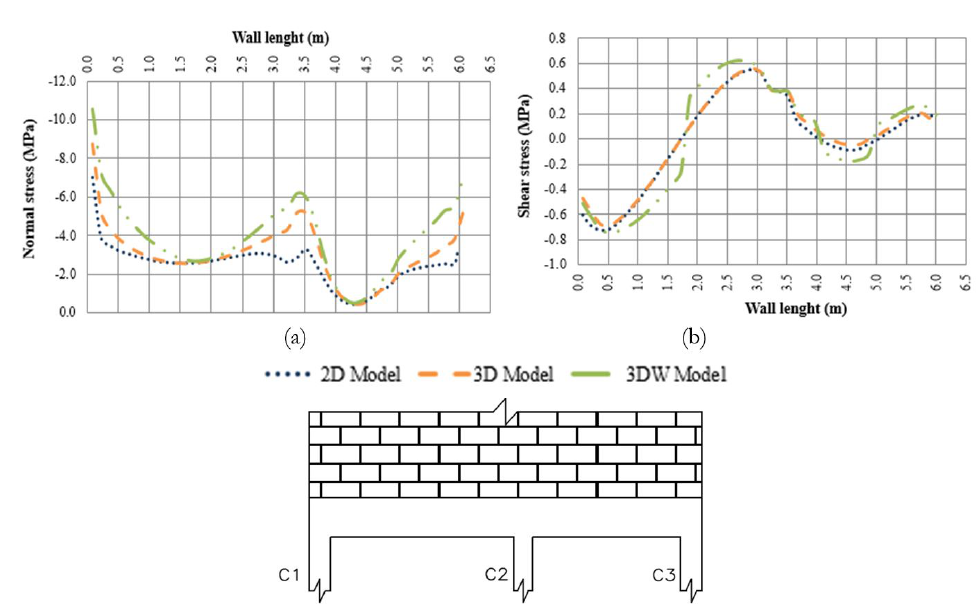
Figure 7. Stress distribution at the bottom of Wall 1: (a) Normal stress; (b) Shear stress